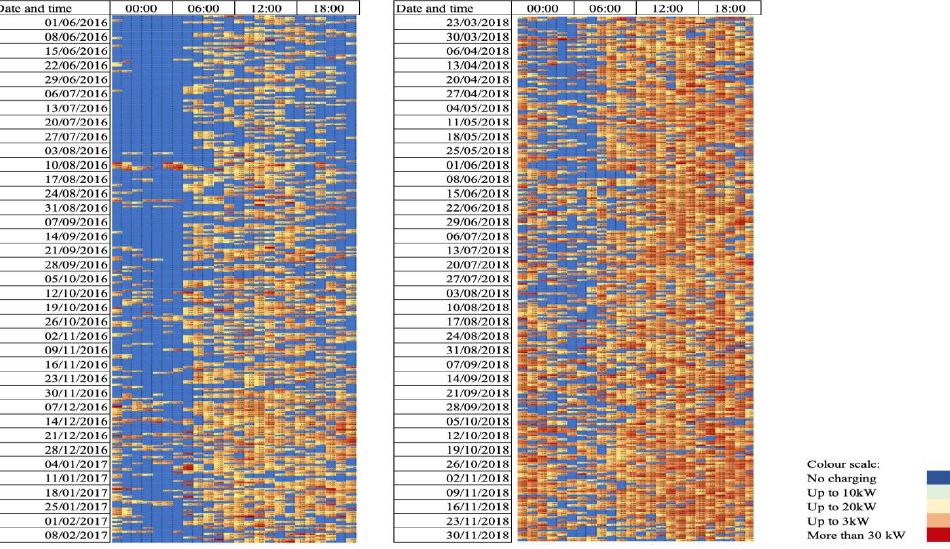
Fig. 2. Visualization of a portion of actual charging station utilization in Bauska and Eizensteina street charging station. Out of all charging sessions 97 % of charging were DC charging: 60 % were CHAdeMO and 37 % CCS. Only 3 % were AC charging